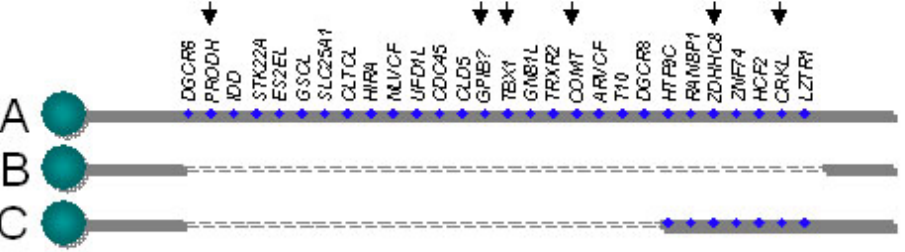
FIGURE 1. Genes eliminated by the two most common deletions in 22q11.2DS patients. (A) Normal human chromosome, (B) deletion present in approximately 90% of the patients, (C) deletion present in approximately 10% of the patients. Genes indicated by arrows are cited in the text. The drawing is not to